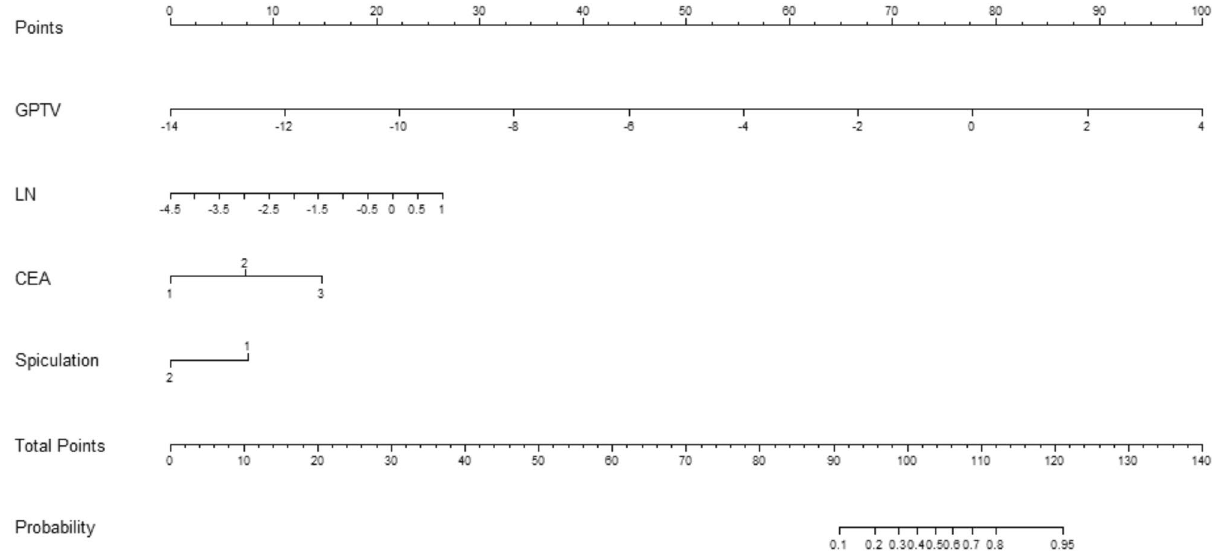
Figure 4. An integrative nomogram incorporating carcinoembryonic antigen (CEA), tumor spiculation and CT radiomics features extracted from gross tumor volume (GTV), peritumoral volume (PTV) and lymph nodes (LN) for the prediction of LN metastasis in patients with cT1N0M0 stage lung